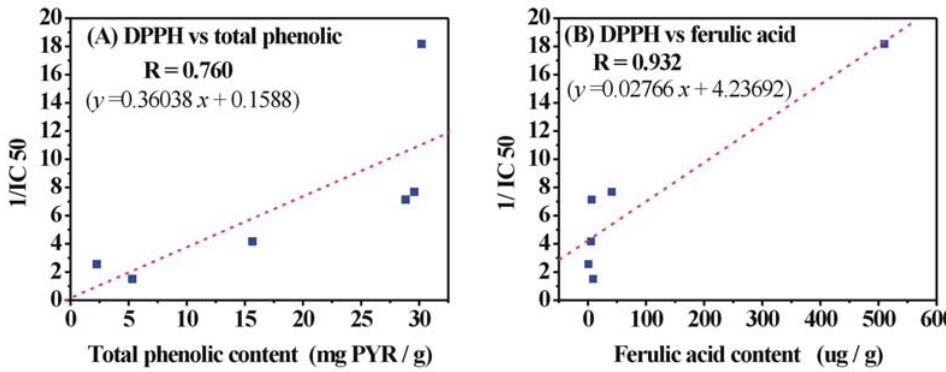
values and (A) total phenolic contents , (B) 50